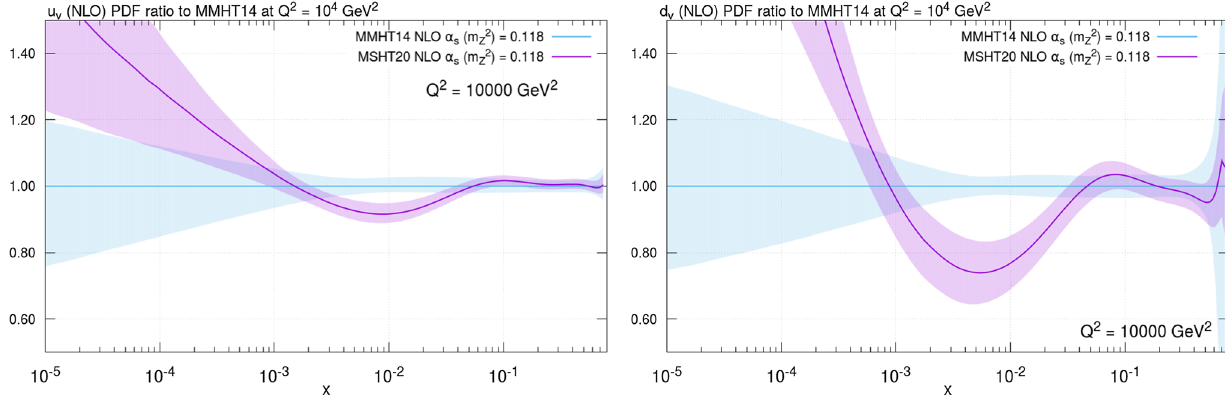
Fig. 35 (Left) u V and (right) d V PDF ratio to MMHT14 at NLO and Q 2 = 10 4 GeV 2